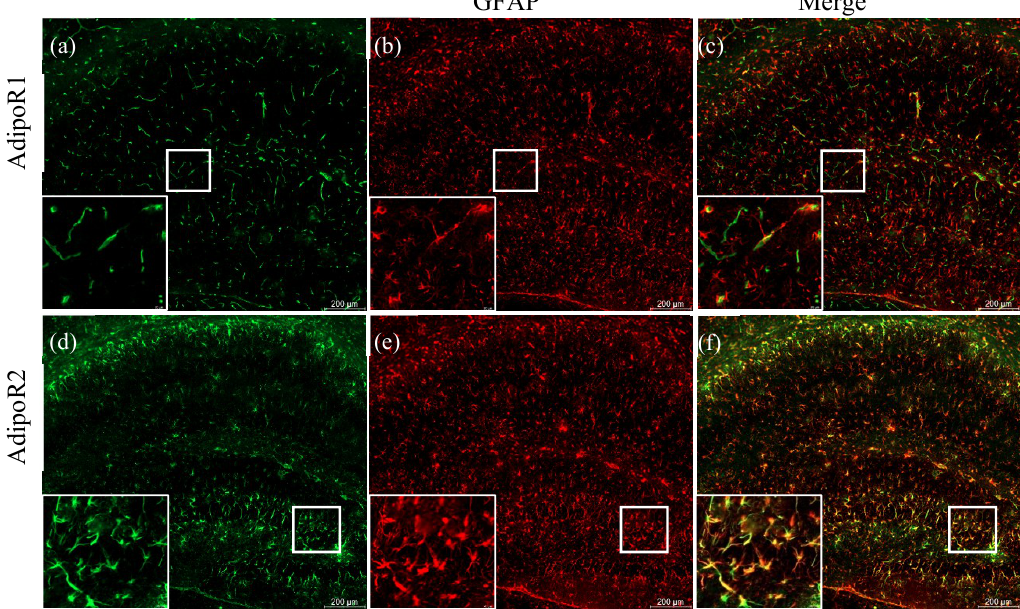
Figure 3. Astrocytic expression of adiponectin receptors in 48–52-week-old 5XFAD mice. Double labelling ofAdipoR1( a )withGFAP( b )showedlittleexpressionofAdipoR1inastrocytes( c ). Significantcolocalisation ( f ) of AdipoR2 ( d ) with GFAP ( e ) demonstrates astrocytic expression of AdipoR2. Images were acquired at 20 × magnification. Scale bars for ( a – f ) are 200 µ m. Scale bars for zoomed-in figures are 20 µ